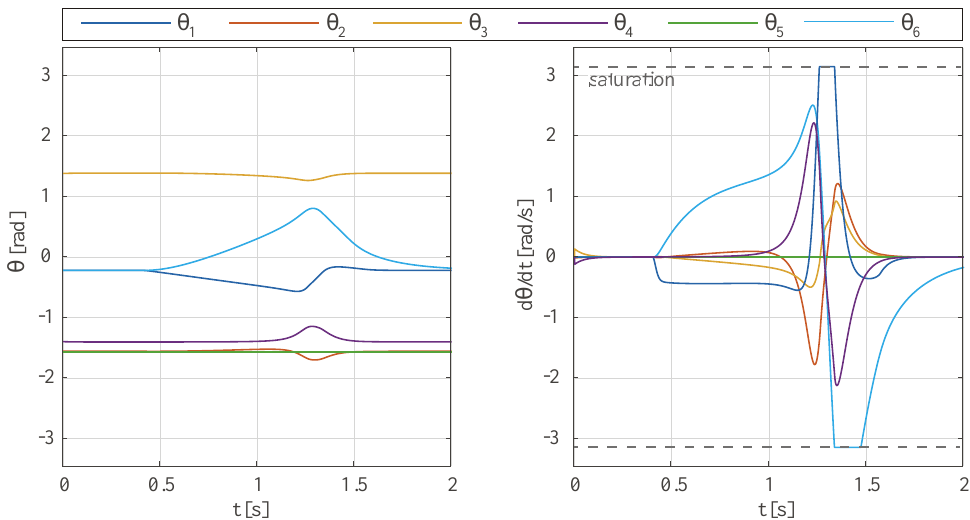
Figure 9. Joint rotations and speeds for the motion shown in Figure 6.